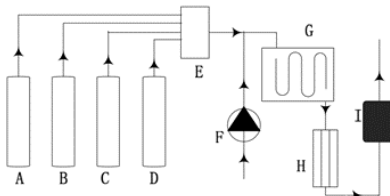
Figure 4. Test system: A, N 2 gas tank; B, O 2 gas tank; C, CO gas tank; D, NO gas tank; E, flow controller;